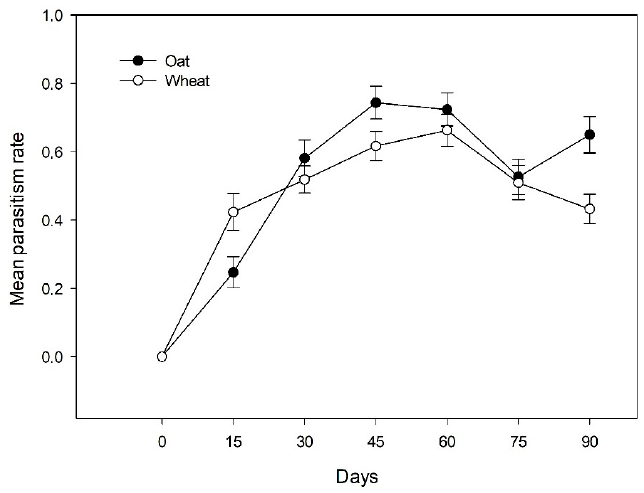
Figure 5. Mean parasitism rates in oat and wheat fields across the different sampling dates.